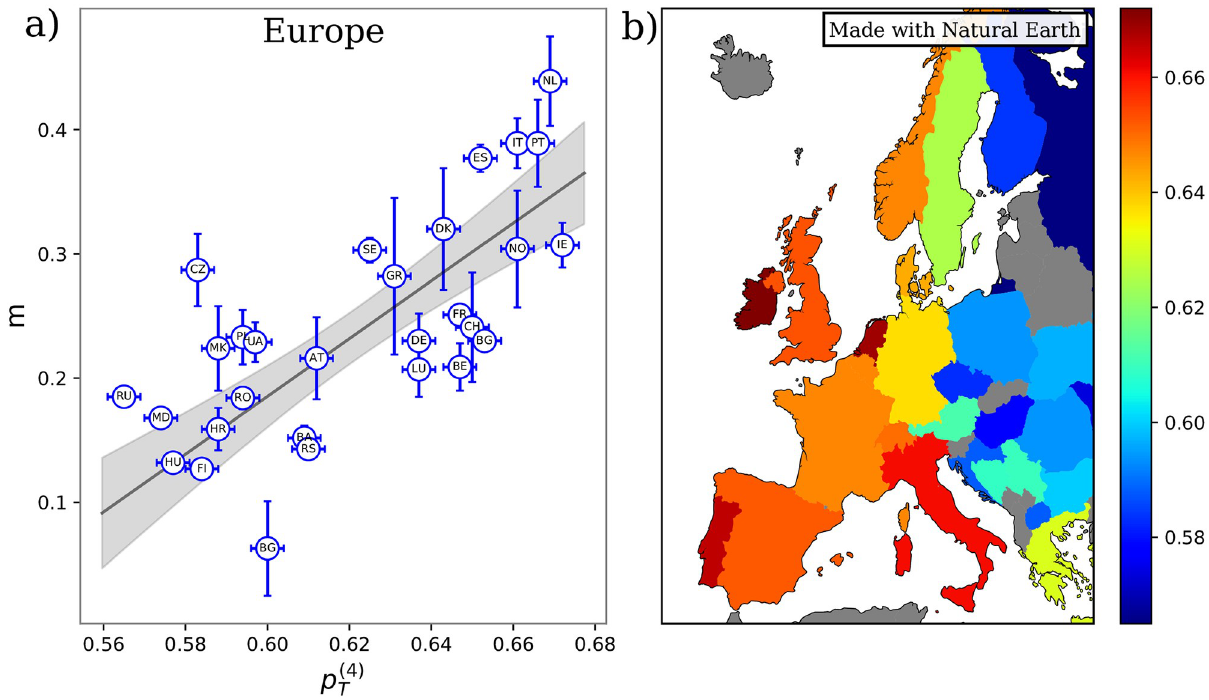
Fig 4. a) Inverse characteristic time of the epidemic exponential phase extracted from cumulative infection curves, m , vs theoretical prediction, p ð 4 Þ obtained from Eq (11) using the ABO set of rules and the blood type frequencies in Table 2. Each dot corresponds to one of the 29 analyzed countries in the European region named according to the 2-letter ISO code and reported in Table 2. The black line represents the best solution of a linear fit performed with the York method and the grey shaded area is the ± one standard deviation confidence band. The uncertainty on p ð 4 Þ